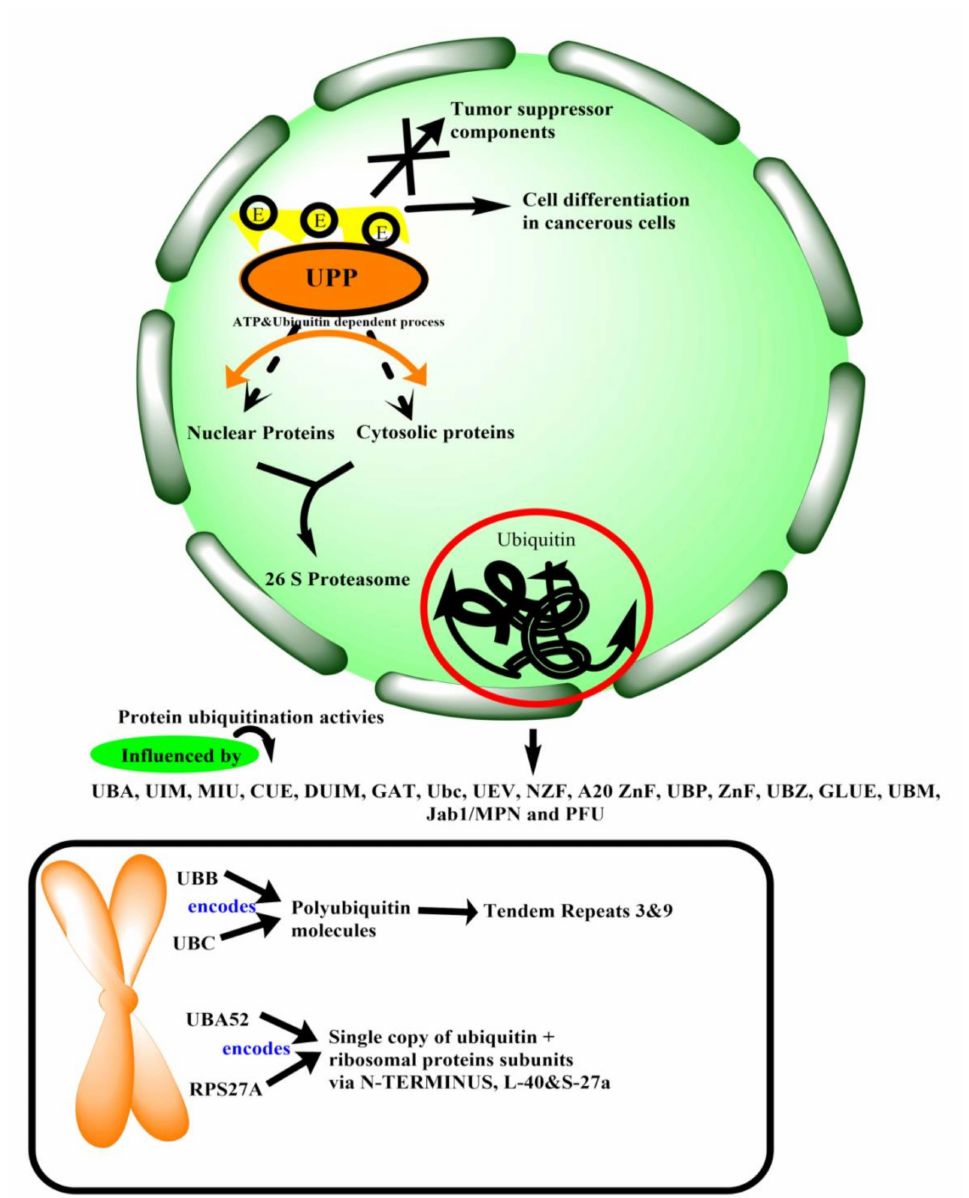
Figure 3. Illustration of ubiquitin in cancerous cells and human genome encodings, i.e., UBB and UBC encode for polyubiquitin molecules and UBA52 and RPS27A encodes for single copy of ubiquitin and ribosomal proteins subunits. Ubiquitin-proteasome pathway degrades nuclear and cytosolic proteins through an ATP- and ubiquitin-dependent process. Ubiquitin polymers are formed by covalent attachment of E1, E2, E3 which involves different enzymes having distinct cell roles that